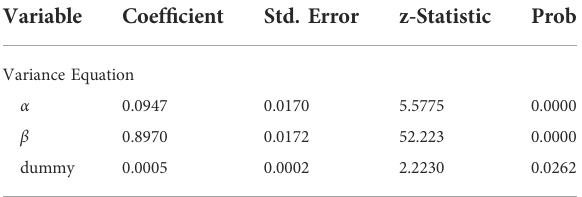
TABLE 17 Parameter estimates of the GARCH (1, 1) model for EUA futures returns in phase II with structural breaks from 2 January 2008, to 31 December